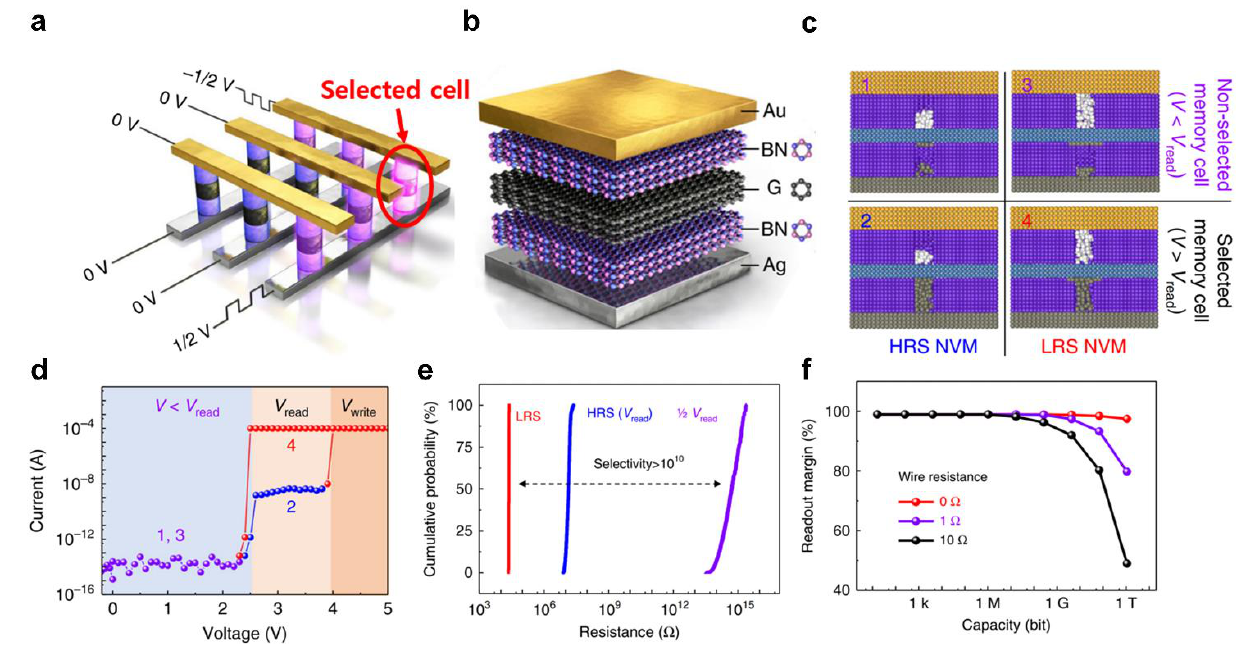
Figure 3. Memristor with a self-selective resistance state. ( a ) Schematic of “selected” cell in the crossbar array, with a total summation of one read voltage. (Red circle) ( b ) Schematic of van der Waals layered structure comprising a hexagonal boron nitride (h-BN/graphene/h-BN layer. ( c ) Operation mechanism of two filamentary memristors separated by a graphene mid-layer, showing four possible device operation states: 1 and 3 show the HRS and LRS in “unselected” mode, exhibiting high resistance, 2 and 4 represent the HRS and LRS in “selected” mode. ( d ) Corresponding three-resistance mode. ( e ) Cumulative probability of each resistance state. ( f ) Calculated readout margin indicting scalability of up to 1 Tbit in the three case scenarios of wire resistance; adapted with per- mission from ref. [87], copyright 2019 Springer Nature.